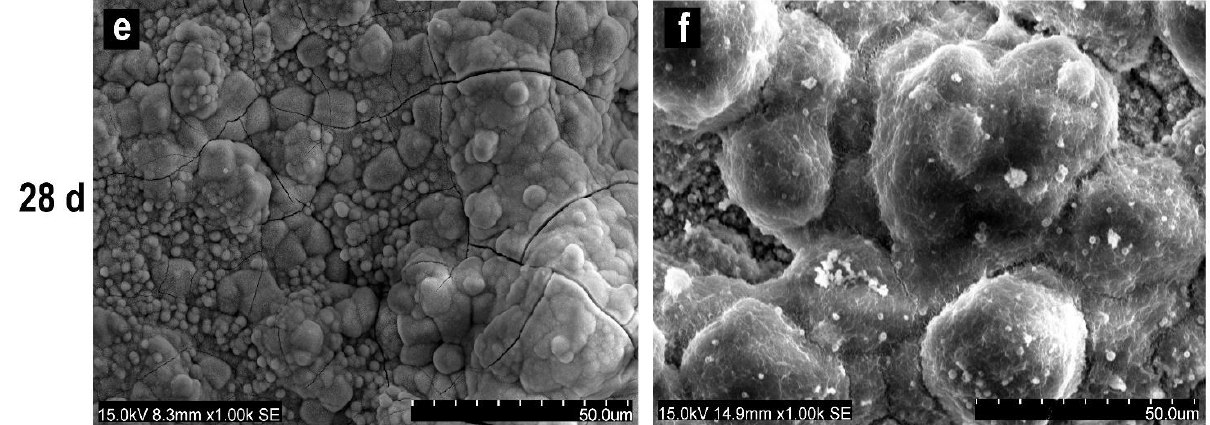
Figure 3. SEM images of CS after immersion in PBS for 1 d ( a ), 7 d ( c ), and 28 d ( e ) showing the